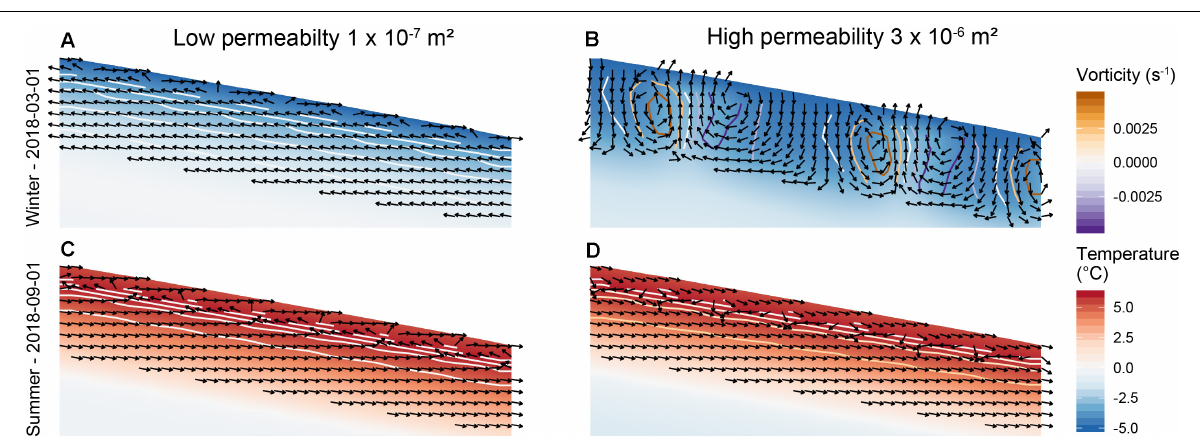
dependent on the ground cover and the corresponding active layer